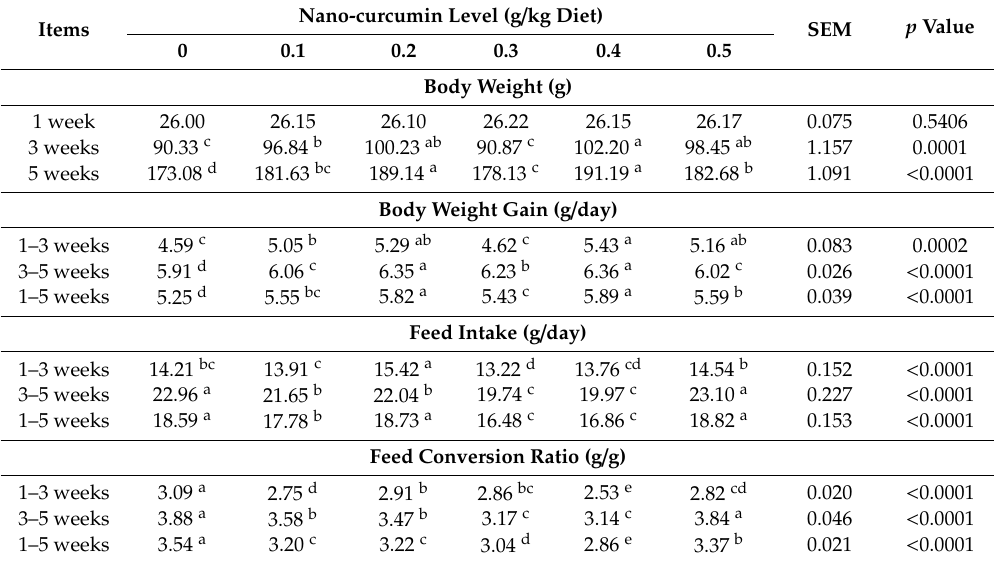
Table 3. Growth performance of Japanese quail as a ff ected by dietary nanocurcumin.